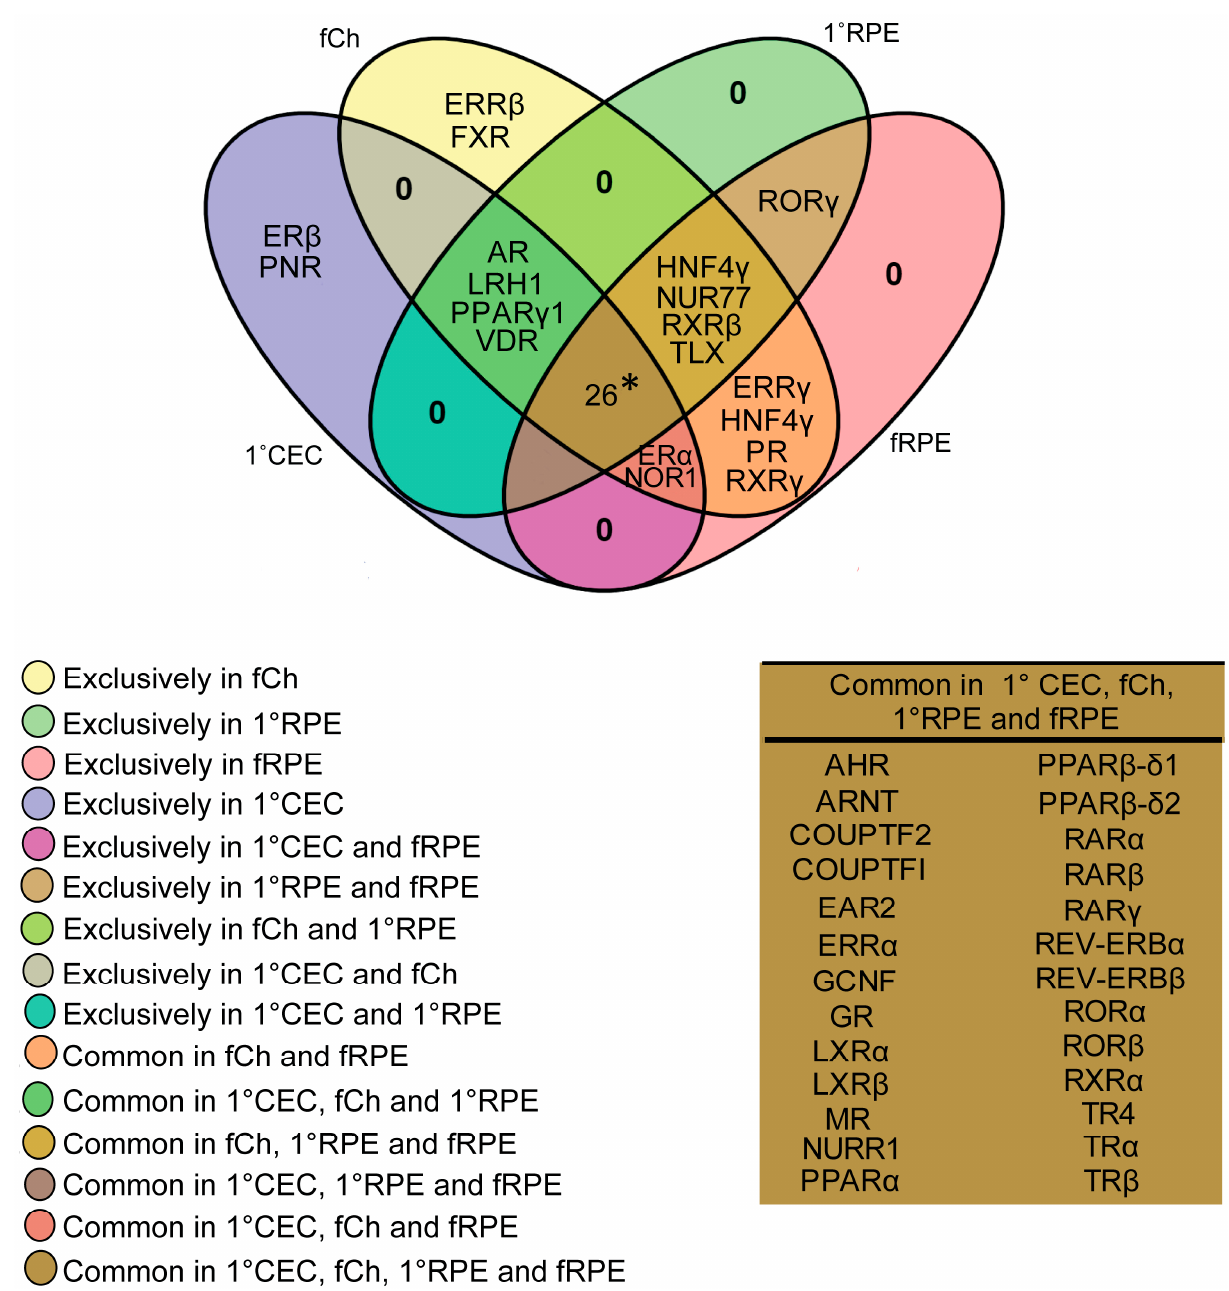
Figure 4. Commonly expressed nuclear receptors in the human choroidal tissue models versus RPE models. Commonly expressed nuclear receptors are shown in a four-set Venn diagram, with an overlap of freshly isolated choroid tissue (fCh), cultured primary choroidal endothelial cells (1 ◦ CEC), freshly isolated retinal pigment epithelial cells (fRPE) and cultured primary RPE is presented here. The Venn diagram was drawn using VENNY 2.1.0. Common nuclear receptors expressed in all four categories are listed in the table with color coded legend. * 26 common nuclear receptors found in all model systems are shown in the adjoining